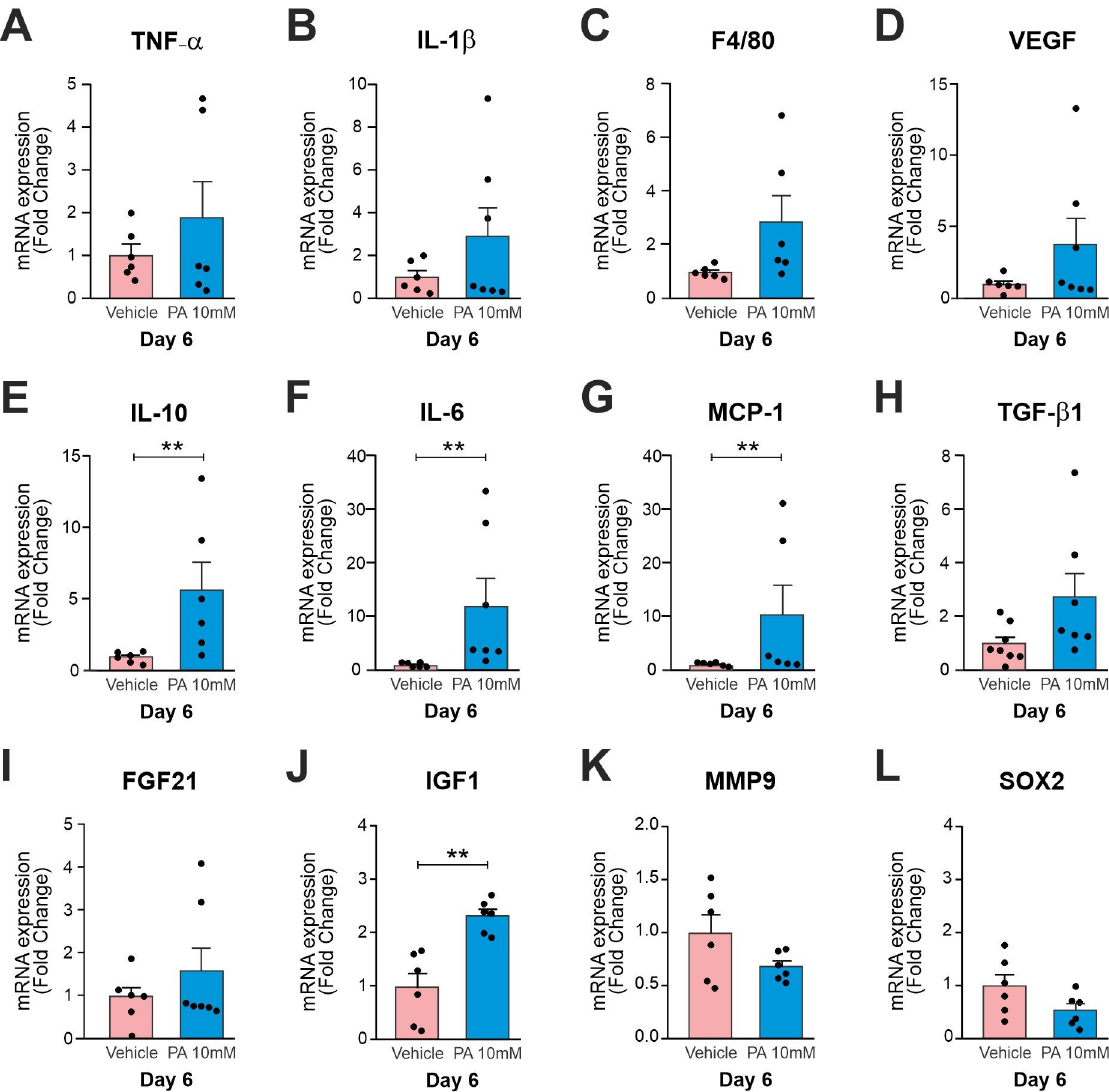
(J), Mmp-9 (K), and Sox2 (L). In all experiments n = 6 � p <